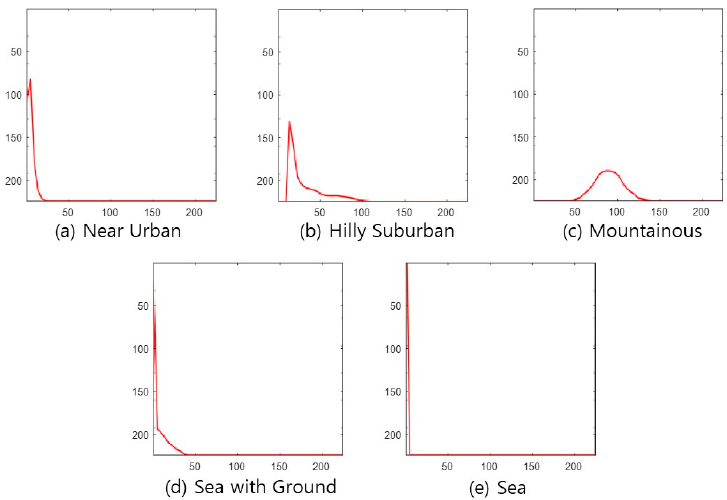
Figure 3. Example of absolute-altitude PMF for each topography class.